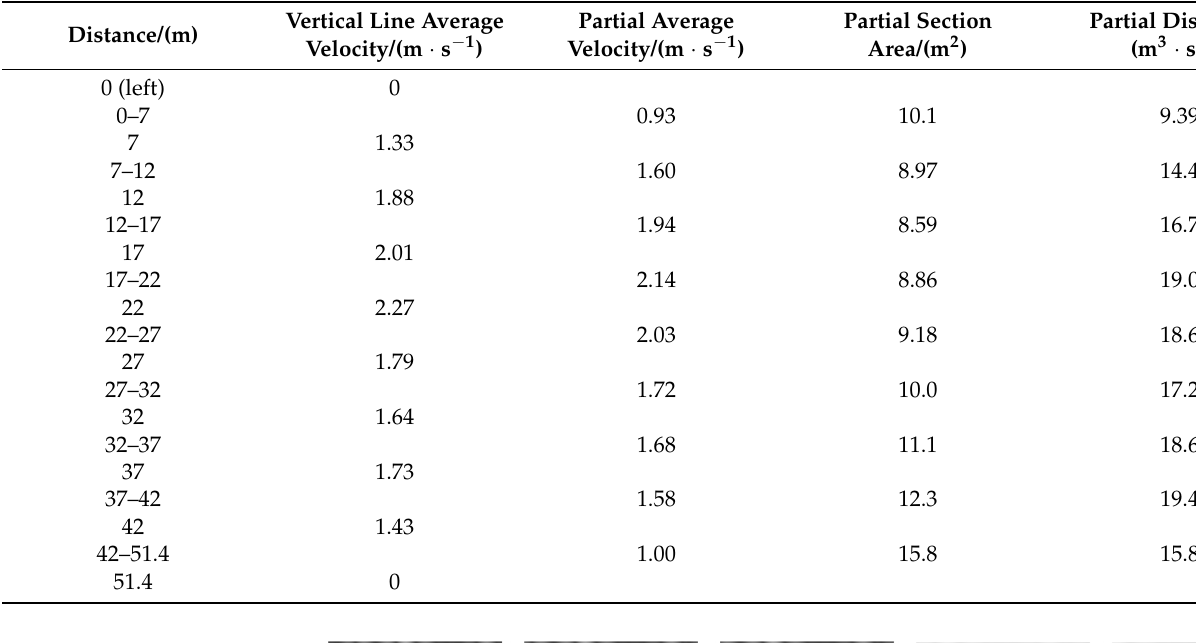
Table 2. Measurement results of the propeller current meter.